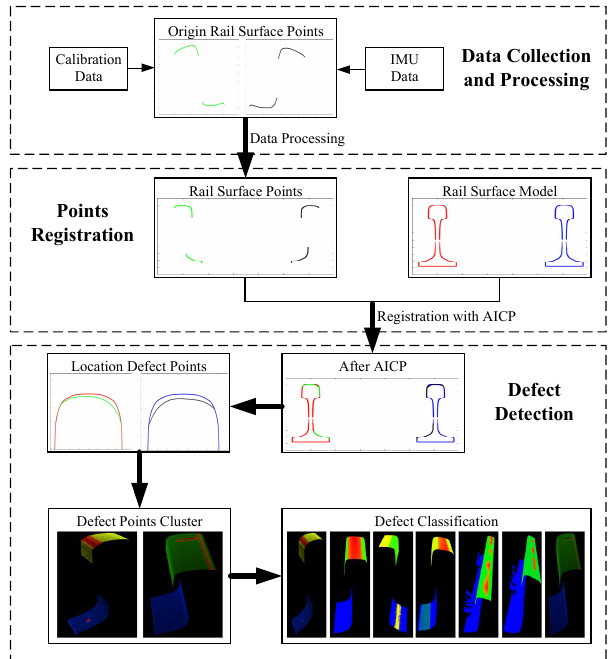
Figure 6. Defect detection and classification